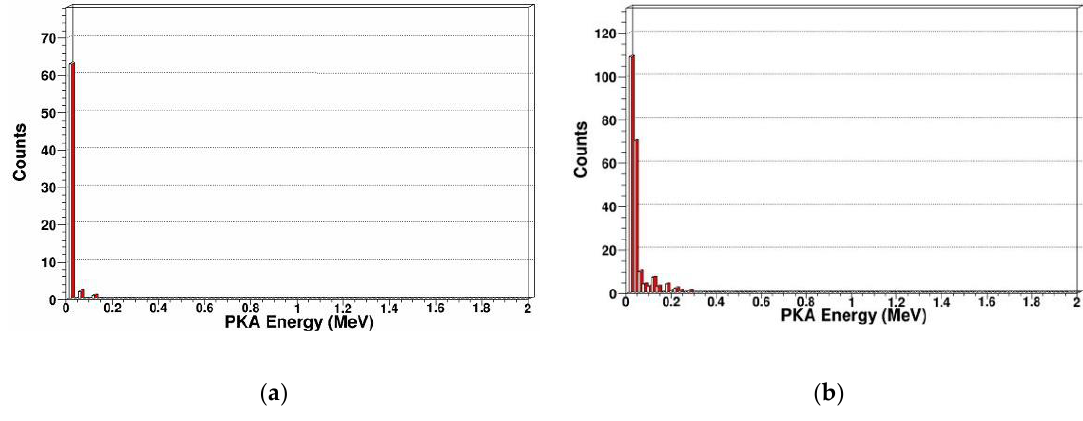
Figure 16. PKA energy spectrum in SDD generated by gammas: ( a ) PKA energy spectrum for 14 MeV gammas; ( b ) PKA energy spectrum for 20 MeV gammas.